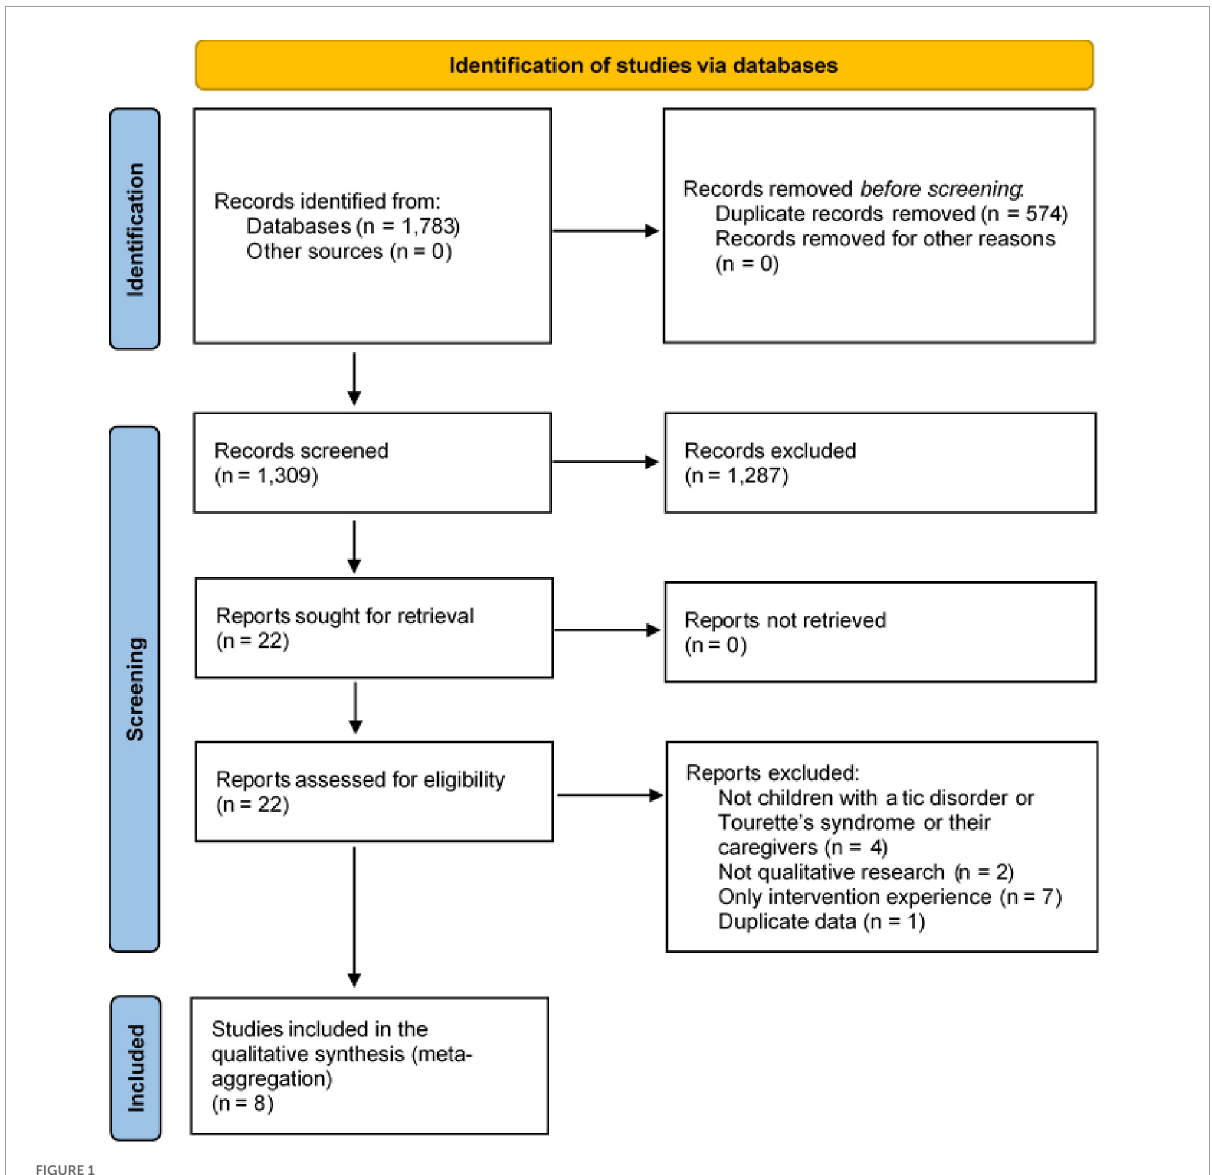
FIGURE1 PRISMA flow